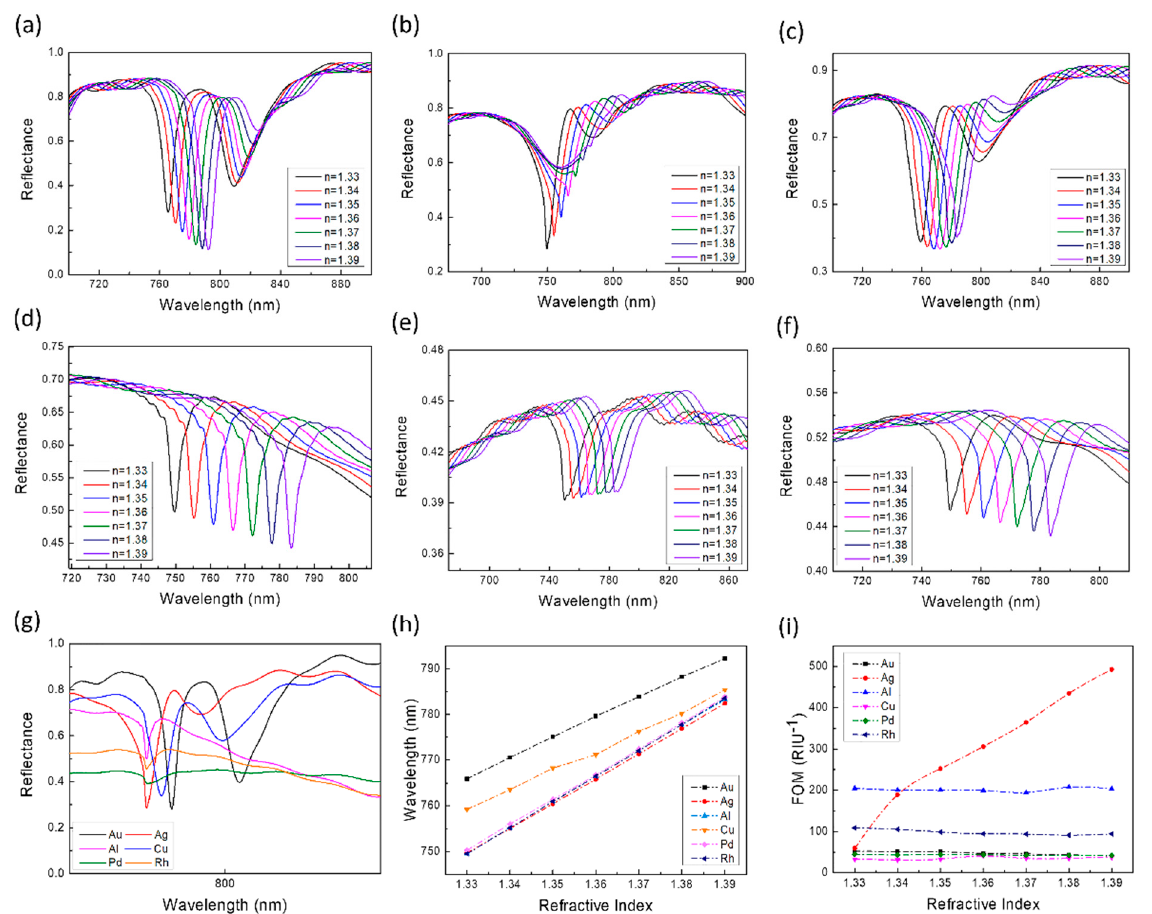
Figure 10. Mode 2 obtained by using different materials under standard structural parameters and within a certain range of refractive index changes: ( a ) Au, ( b ) Ag, ( c ) Cu, ( d ) Al, ( e ) Pd, ( f ) Rh. ( g ) When n = 1.33, the spectra of sensors of different materials in the mode 2 band. ( h , i ) is the sensitivity and FOM of the sensor by using different materials. (The dashed line connecting the data points is simply connected with a smooth curve for readers as a guide for an eye.). Table 2. Sensing performance and accuracy of different material of designed structure.